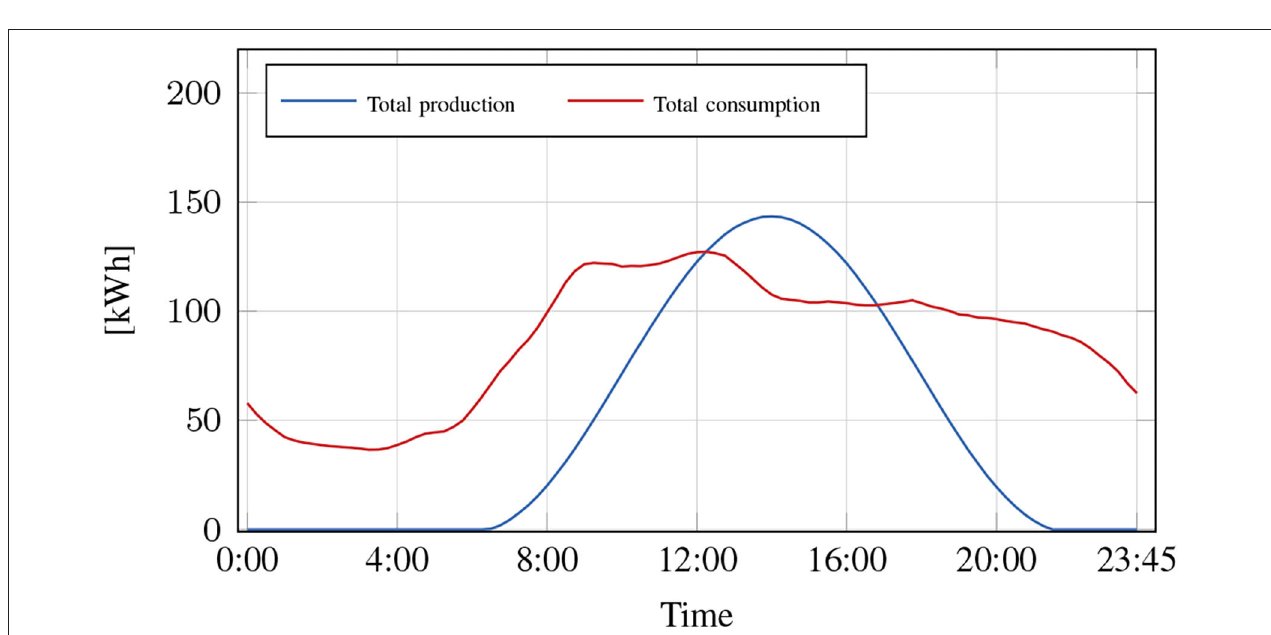
FIGURE 6 | Load profile (i.e., total Consumption) and generation Profile (i.e., total production) in kWh per 15 min intervals aggregated across the